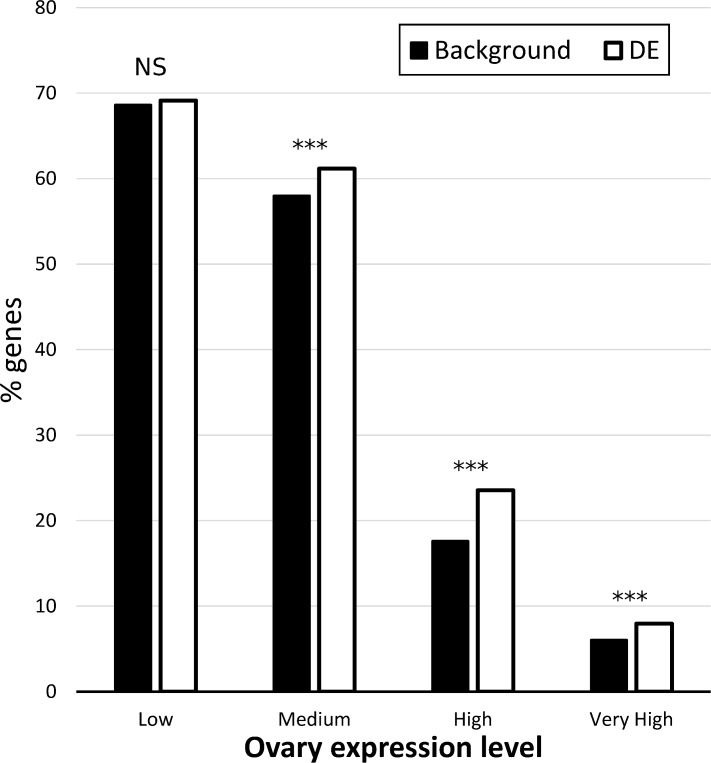
Percentage of contigs with a low, medium, high or very high expression level in female ovaries in our transcriptome data (background, black) compared to the ones found to be DE between diapausing and non-diapausing females (white).P values are from a one-sided Fisher’s exact test, see text for details: NS = P > 0.05, ***P < 0.001.